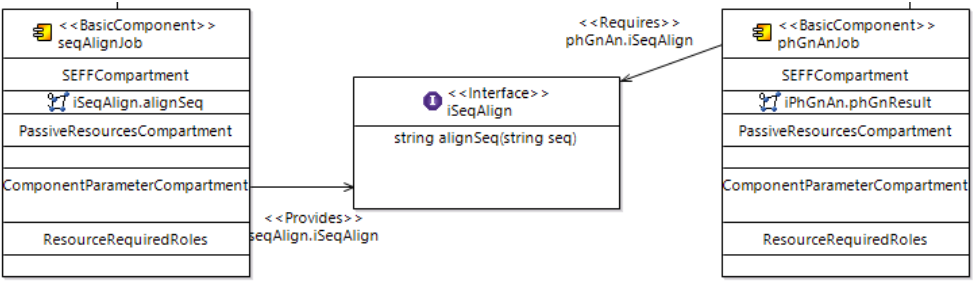
Figure 4. Part of the repository diagram.